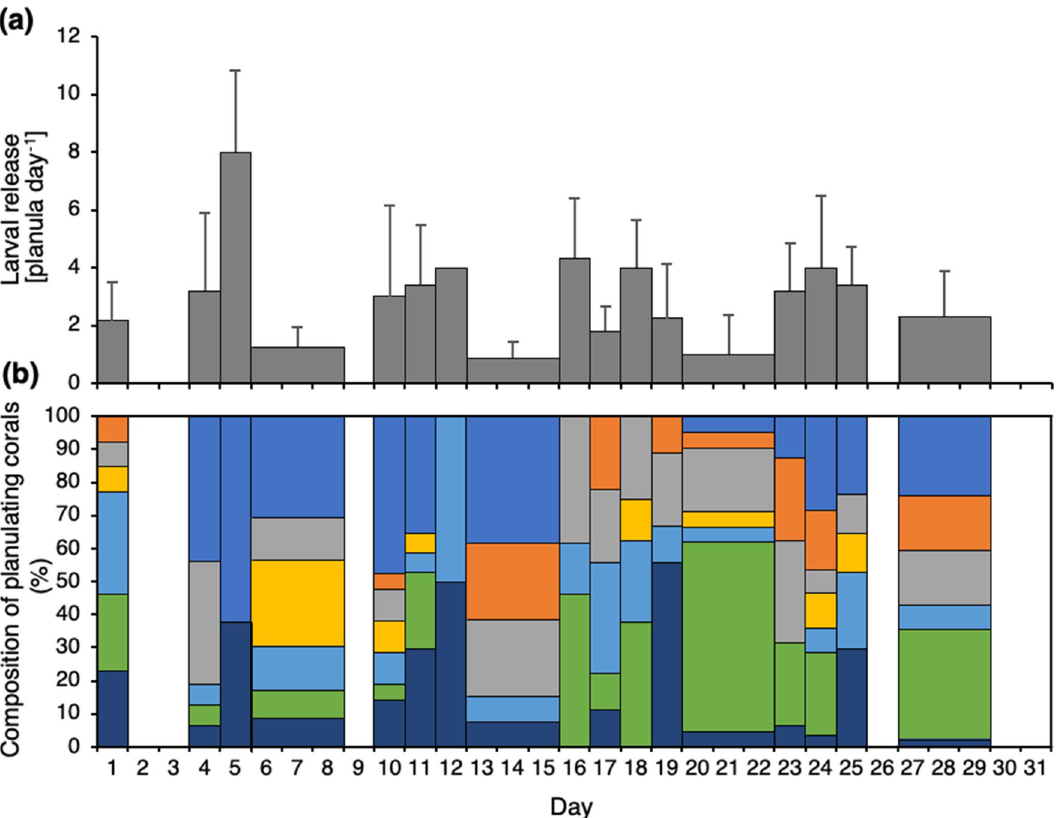
Figure 3. Daily larval release among the seven Caryophyllia huinayensis polyps during the most active month (October 2018). ( a ) Planula per coral and daily release rate (mean ± SD), and ( b ) composition of planulating corals, with the color-coded bars representing each of the seven parental polyps included in the study. Note: Broad bars indicate values averaged over the weekend, as larvae were monitored from Monday to Friday; no larvae were released on 2nd, 3rd, 9th, 26th, 30th, 31st of October 2018.